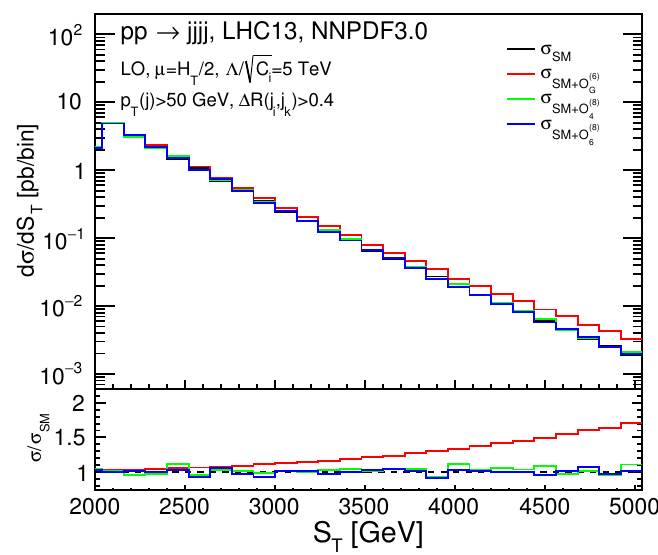
Figure 6 . Impact of the dimension-8 operators of eqs. (2.1){(2.2) on the S T observable. A maxi- mum of one insertion of each operator is allowed at the amplitude level and all terms up to O (1 = (cid:3) 8 ) are